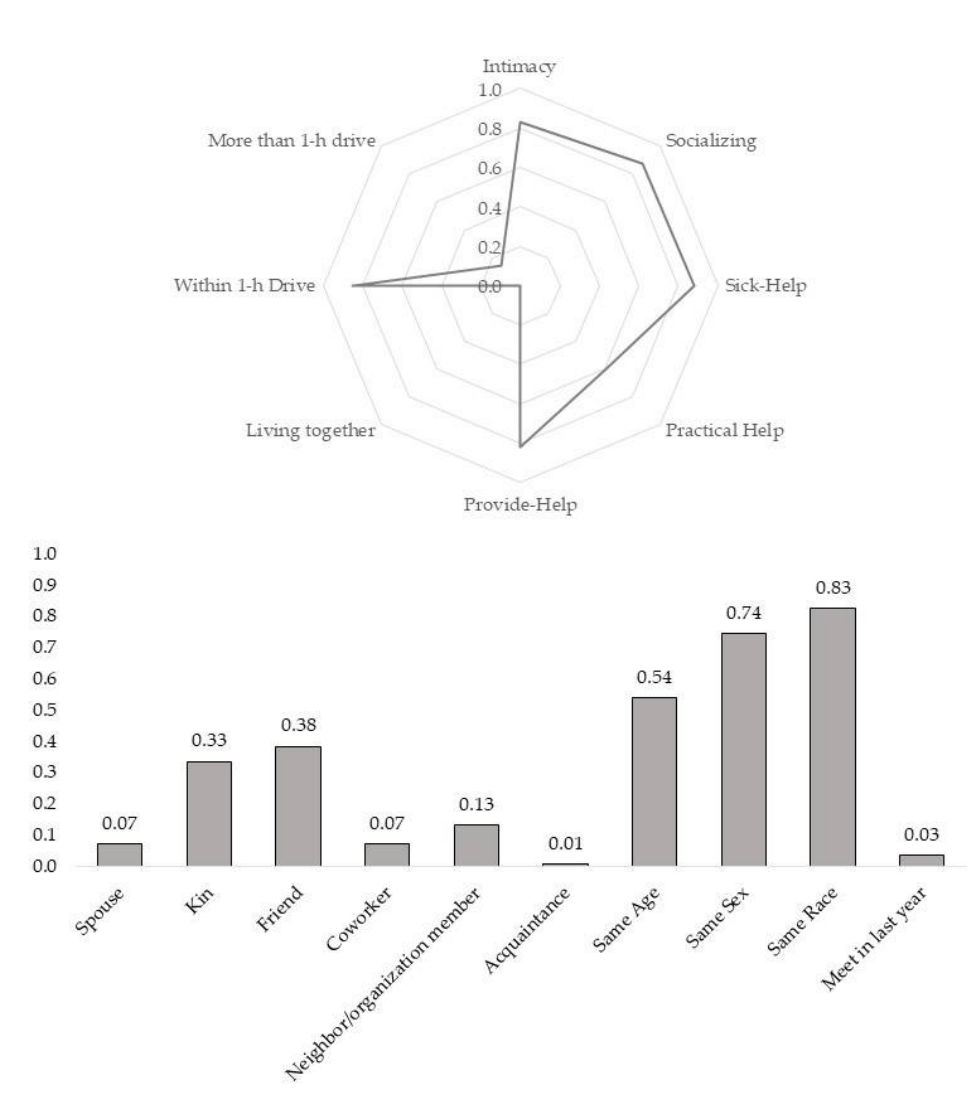
Figure 2. Close neighbor type.